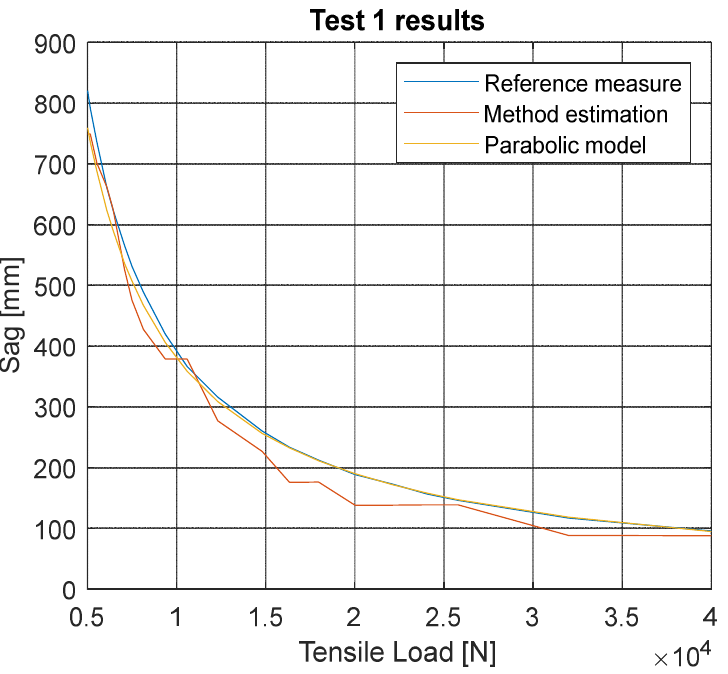
Figure 5. Comparison of the sag values estimated through the proposed method (red curve) with the reference measured values (blue curve) and the ones from the parabolic model (yellow curve) during Test 1.